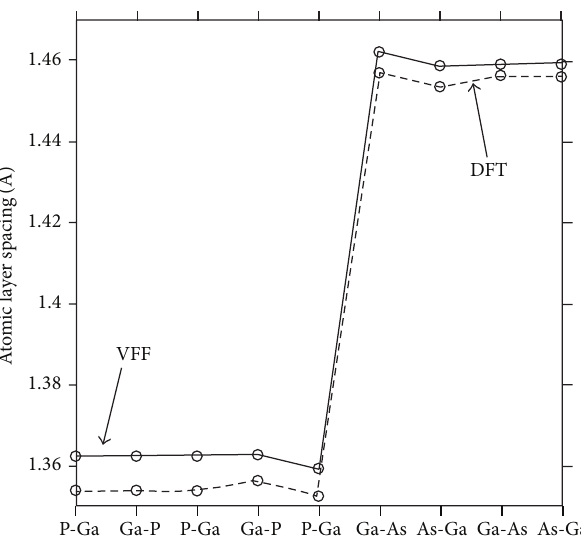
Figure 7: Variation of the atomic interlayer spacing close to a P-Ga- Asinterface,simulatedbytheDFT(dashedlineandcircles)andVFF method (straight line and circles) for short-period GaAs(4)/GaP(4) [001] superlattices.